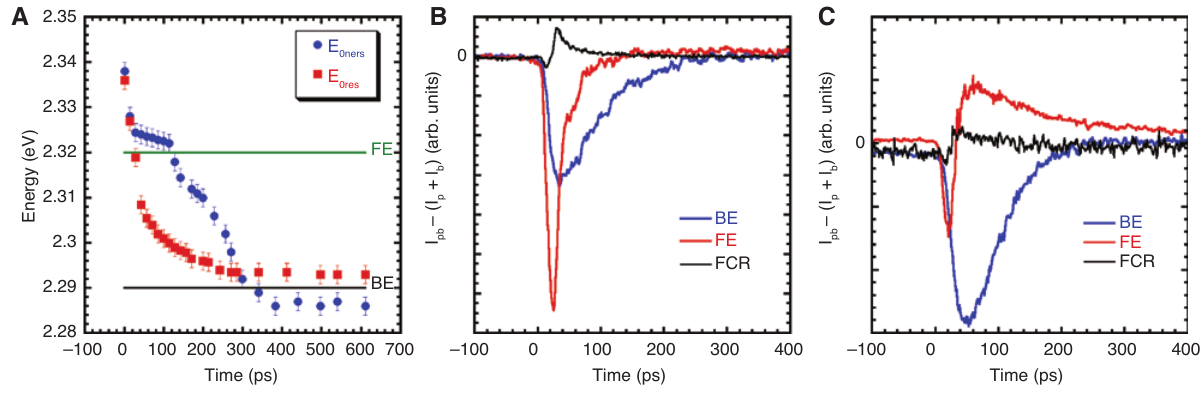
Figure 7: Bulk sample. (A) Time evolution of the zero-crossing energy E . (B), (C) Nonlinear contribution evaluated as indicated in the text for the bulk sample when 0 nonresonant (B) or resonant (C) bias is used for three different spectral regions: the bound exciton (BE), the free exciton (FE), and the free carrier recombination (FCR).